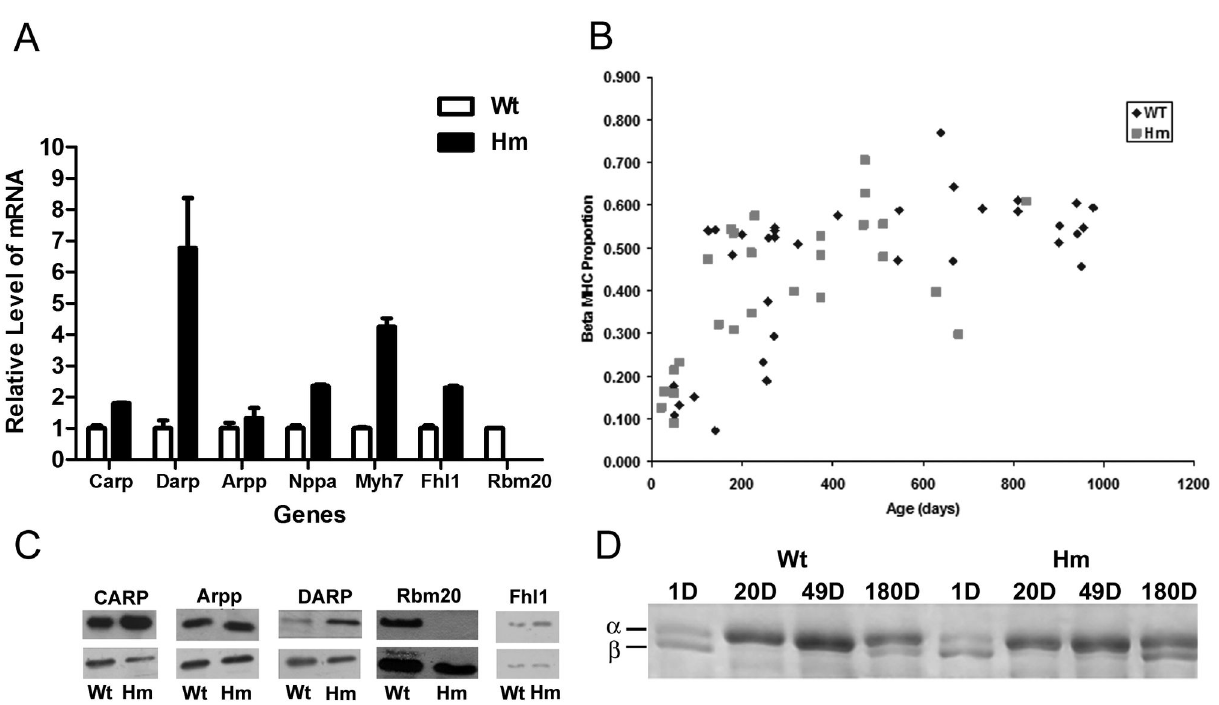
Figure 4. Expression levels of selected genes. A. Quantitative real time RT-PCR verification of microarray results for selected genes; wild type value set at 1.00 for each gene; all data are from an average of triplicates (P<0.05). C. Western blot analysis of MARPs and Rbm20. B and D. Left ventricle beta myosin heavy chain proportion and electrophoresis with various ages in the different phenotypes. D: day; Wt: wild type; Hm: Homozygote mutant.